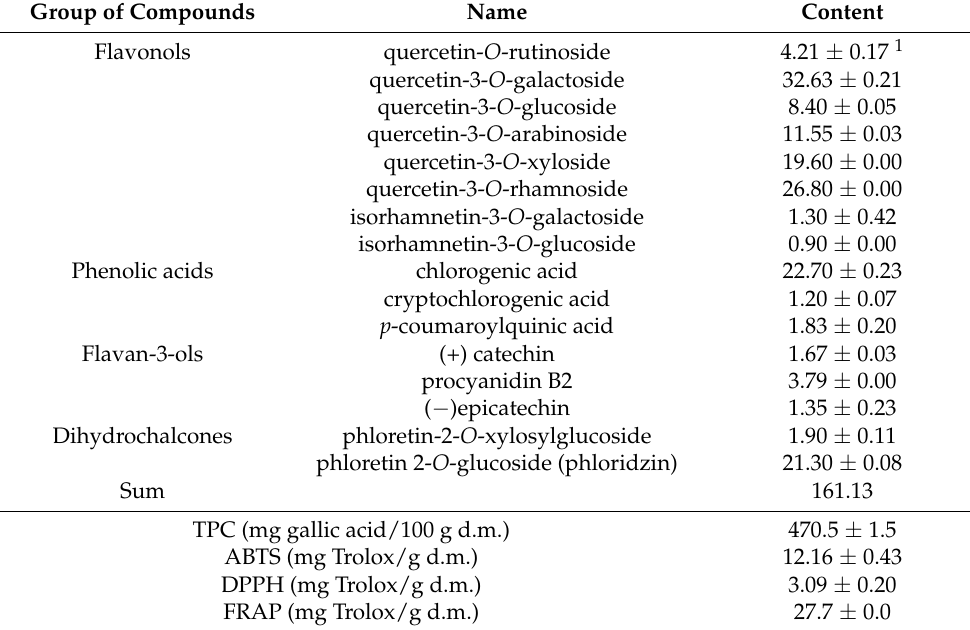
Table 2. Quantity of phenolic compounds (mg/100 g d.m.) and antioxidant potential of apple pomace ( n =